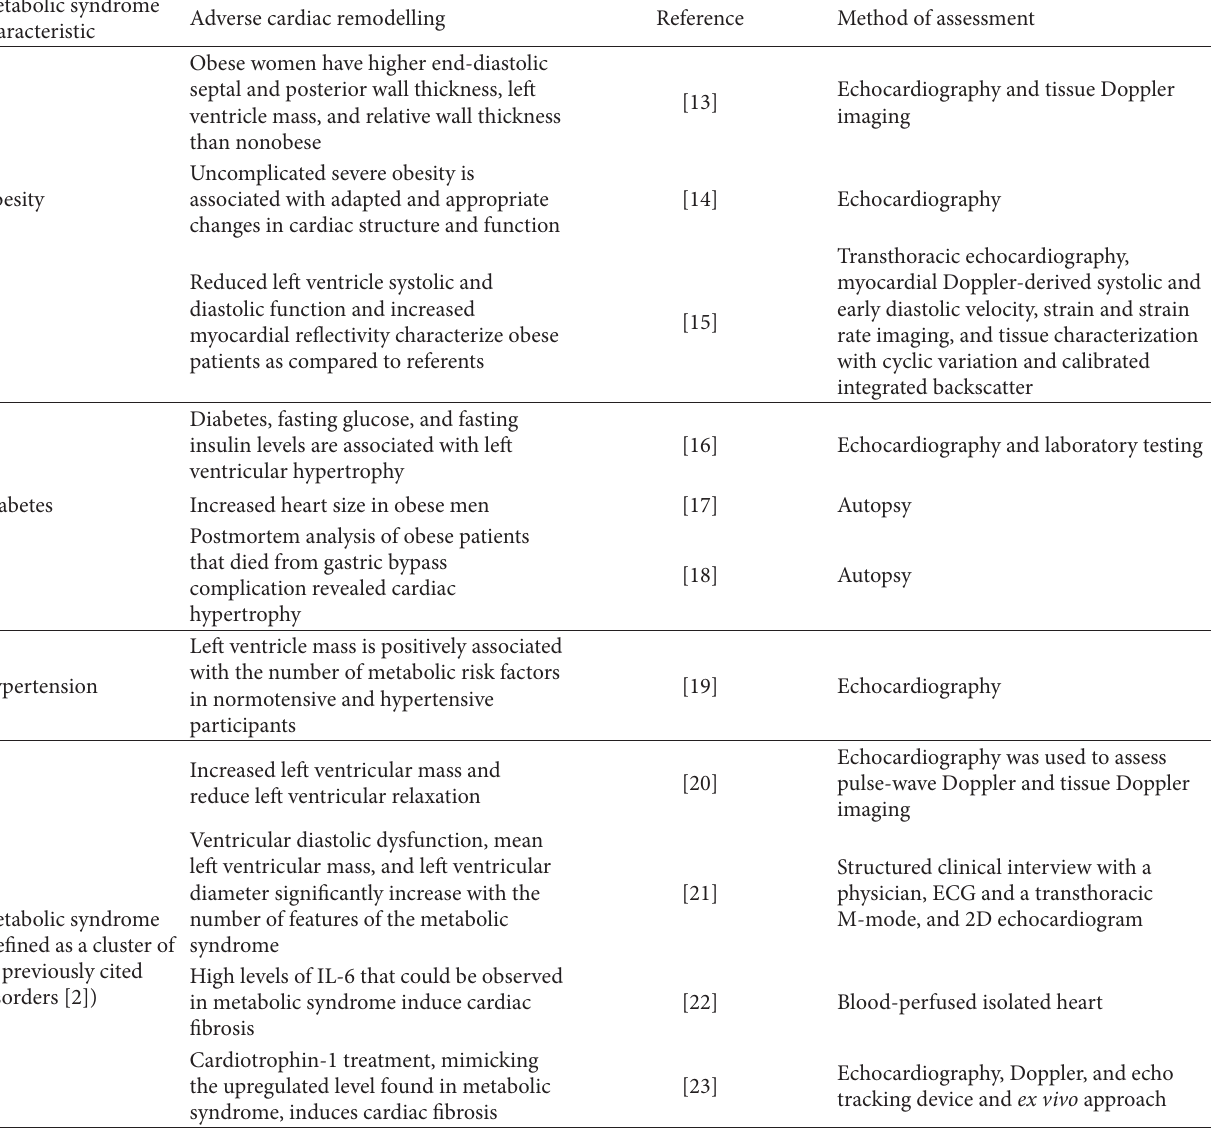
T 1: Different disorders in metabolic syndrome are associated with cardiac structural and functional